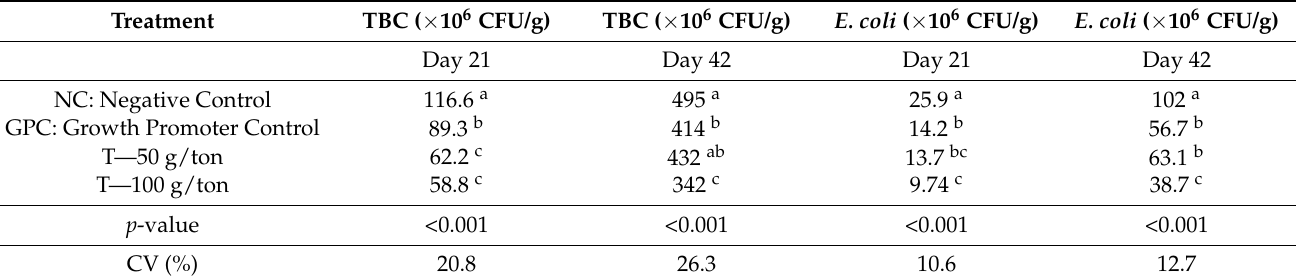
Table 5. Total bacterial count (TBC) and Escherichia coli (EC) in poultry litter of broilers fed an antimicrobial blend to replace growth promoters.